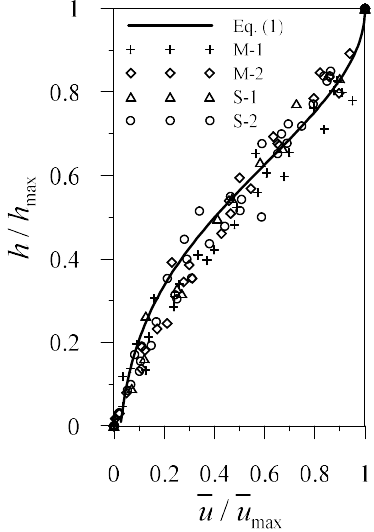
Figure 5. Comparison of the normalized mean velocity profiles in zone ab (Figure 4).